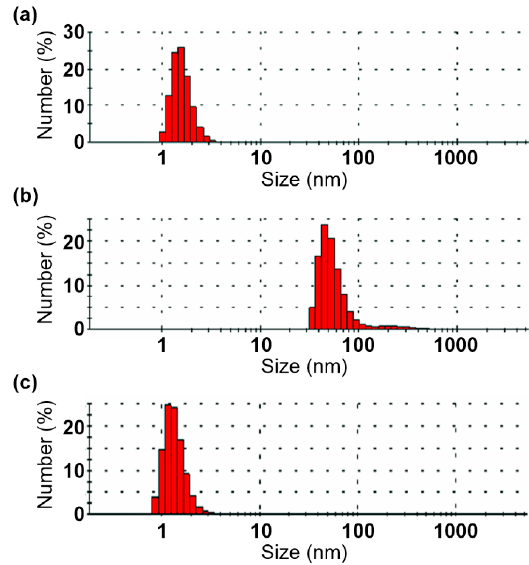
Figure 6. Size distributions of SP-PMOVE in EtOH ( a ) without UV irradiation, ( b ) upon UV irradi- ation for 5 min, and ( c ) after standing of the sample in the dark for 20 min determined by DLS.